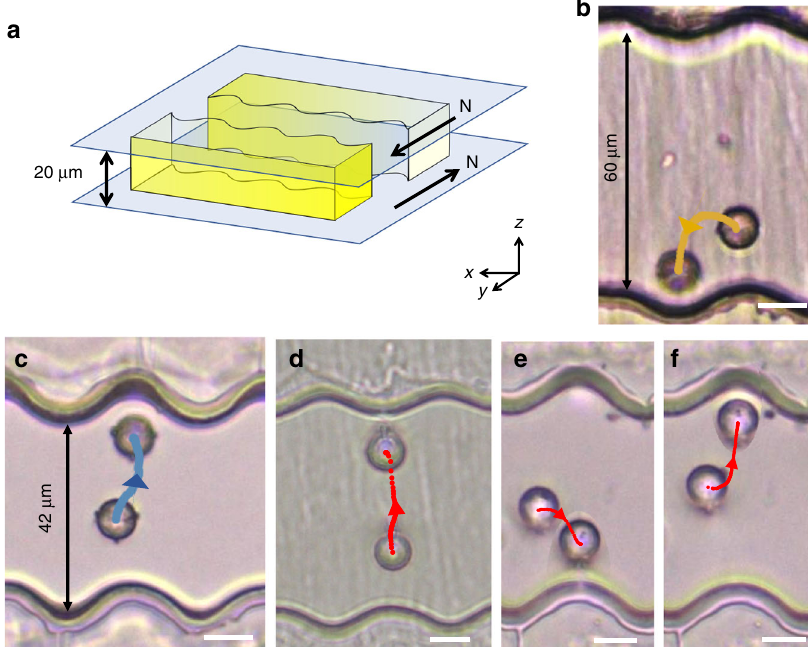
Fig. 7 Repulsion and bistable docking of dipoles and Saturn rings. a Schematic of two parallel walls with a gap comparable to 2 λ between them. b , c A magnetic particle with a Saturn ring defect, placed near a hill, with wall to wall separation ( b ) 60 μ m and ( c ) 42 μ m. In b , the particle is more attracted to the wall on the same side. In c the particle is repelled from the hill, and traverses the separation between walls to dock in the well on the opposite side (2 a = 9 μ m). d – f Behaviors of the dipoles. The waves of the wall are either out of phase with hill to hill con fi guration such as in d or in phase with hill to valley such as in e , f . The scale bars are 10 μ